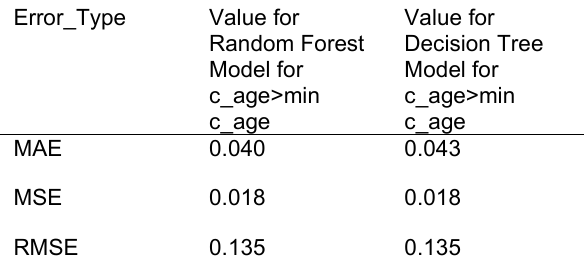
Table 7. Values of MAE, MSE, RMSE for overall data set for the Random Forest and Decision Tree Models for c_slope=2